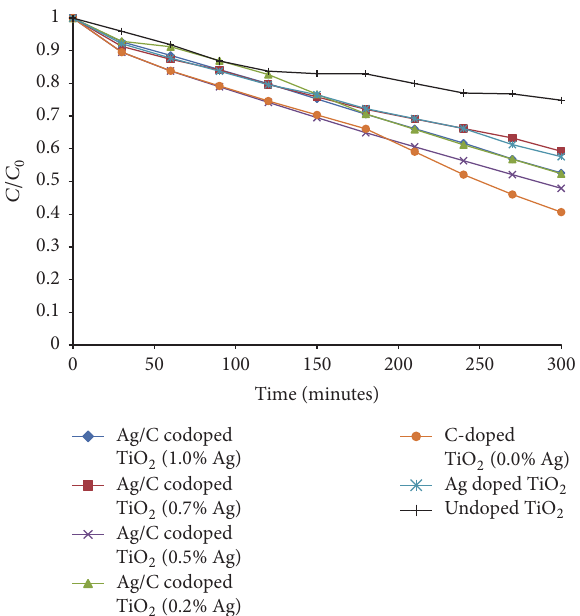
Figure9:Photodegradationof10 ppmmethylorangesolutionusing Ag/C codoped TiO 2 photocatalysts with different contents of Ag under visible light irradiation at 25 ∘ C and pH